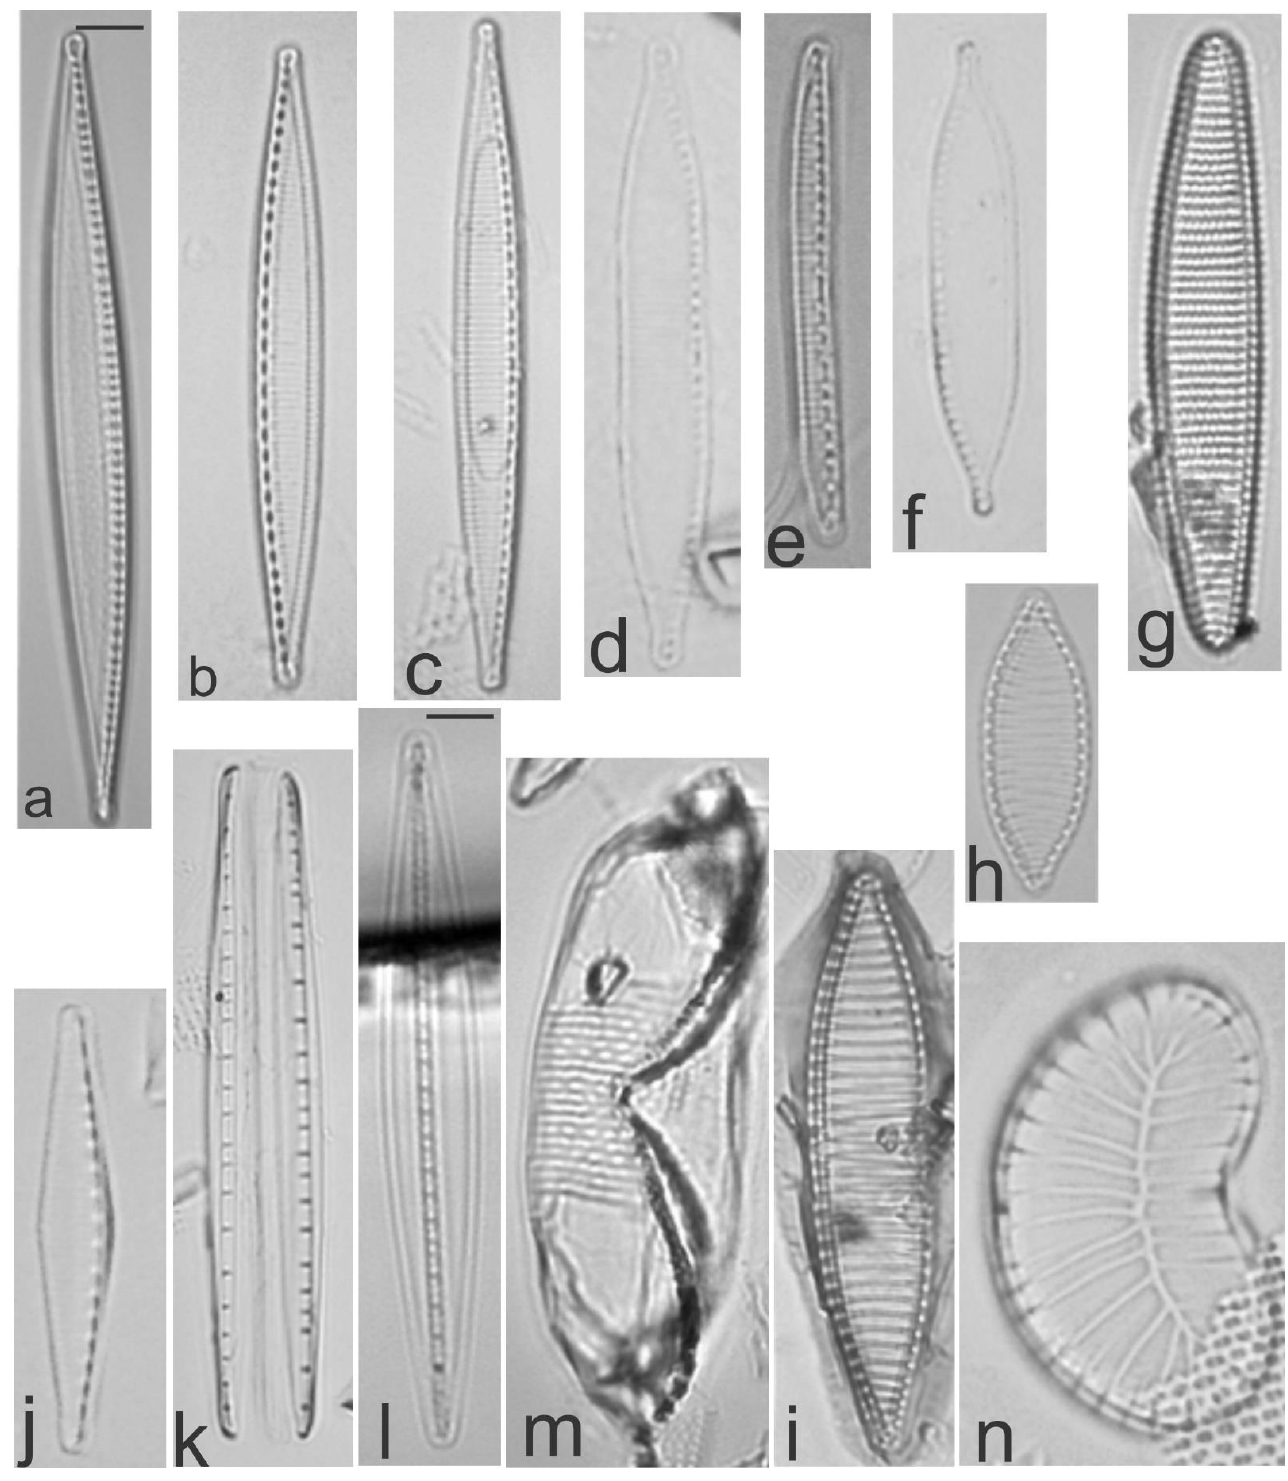
Figure 33. ( a ) Nitzschia sigma ; ( b , c ) N. subacuta ; ( d , f ) N. tubicola ; ( e ) Cymbellonitzschia banzuensis ; ( g ) Fragilariopsis doliolus ; ( h , i ) Nitzschia sicula ; ( j ) N. tenerifa ; ( k , l ) N. angularis ; ( m ) N. nienhuisii ; ( n ) Plagiodiscus nervatus . Scale bar = 5 μm.